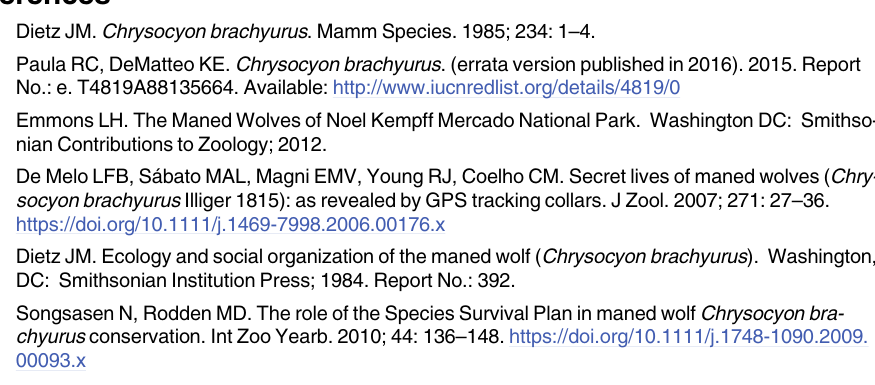
S1 Table. VOCs that differed significantly between paired and unpaired male maned wolf urine samples. S2 Table. VOCs that differed significantly between paired and unpaired female maned wolf urine